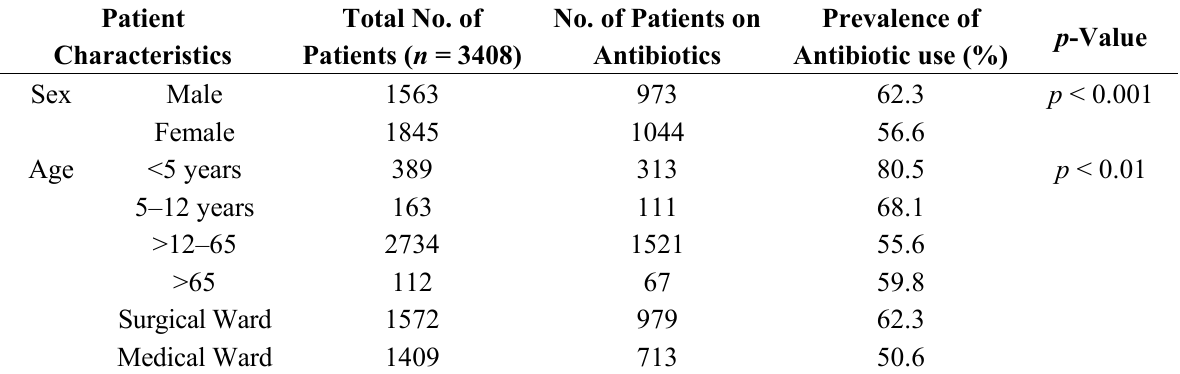
Table 1. Prevalence of Antibiotic Use in 18 Egyptian Hospitals, March